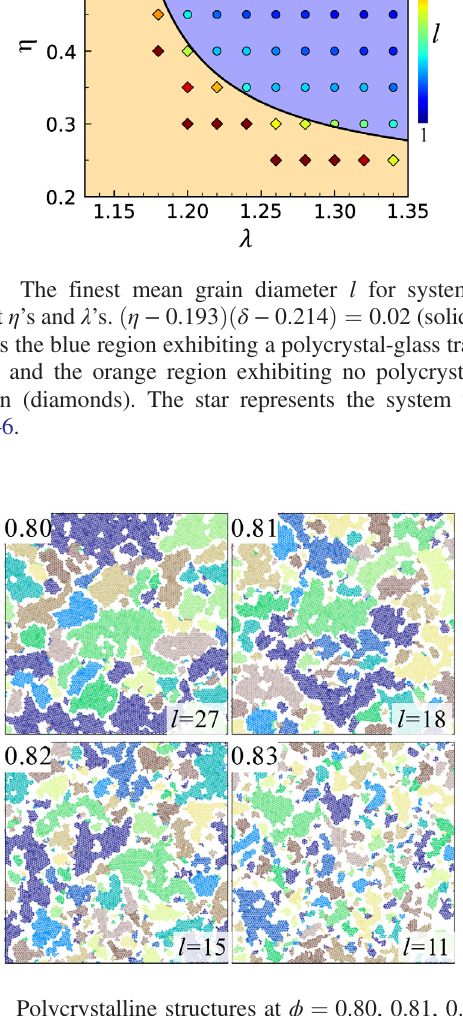
FIG. 8. Polycrystalline structures at ϕ ¼ 0 . 80 , 0.81, 0.82, and 0.83 for the system with shoulder width λ ¼ 1 . 28 and soft particle fraction η ¼ 0 . 25 . Its ð η − η 0 Þð λ − λ 0 Þ < 0 . 02 ; hence the system remains in a polycrystal instead of a glass at the highest ϕ . Note that it is difficult to compress the system beyond ϕ ¼ 0 . 83 , which 0 . 847 of binary is near the random close packing ϕ rcp ¼